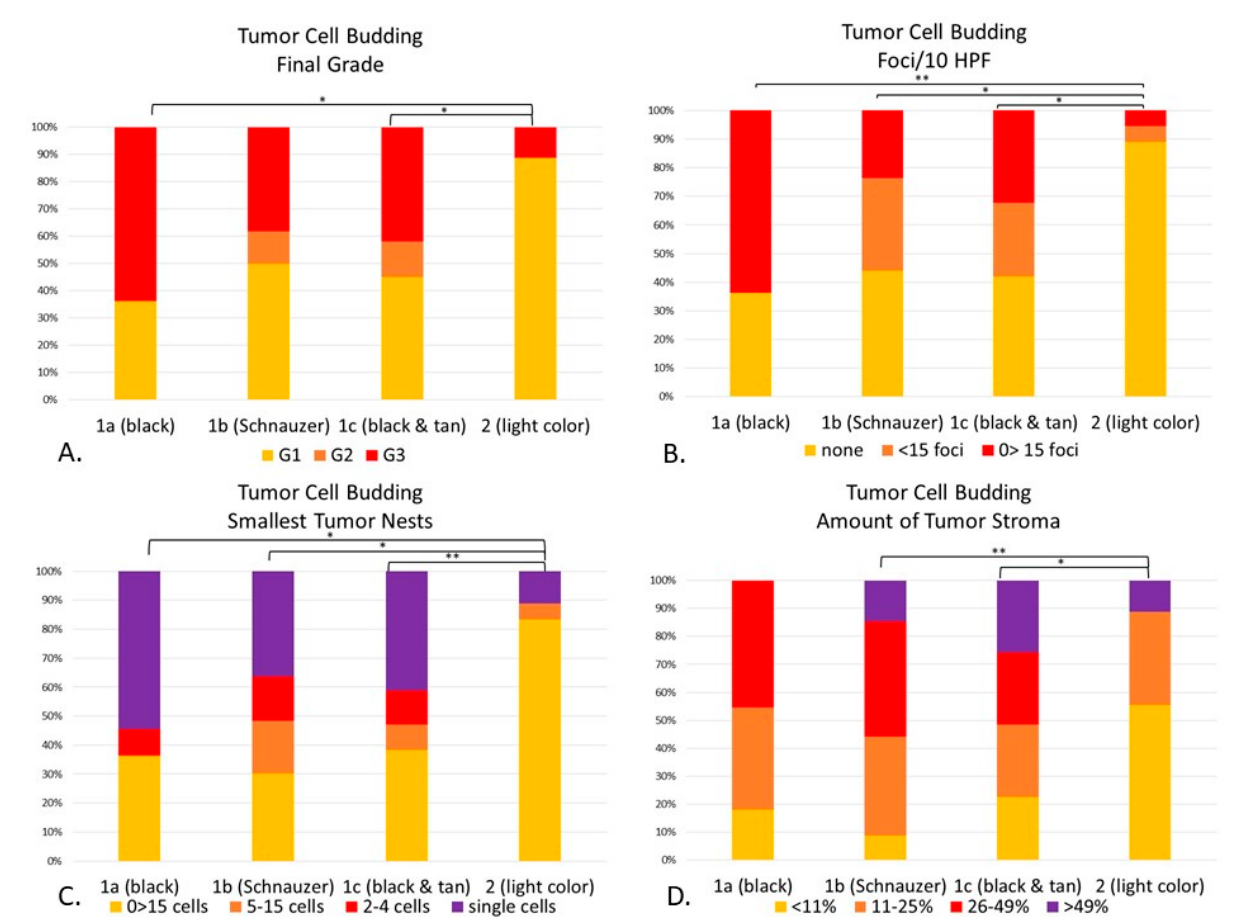
Figure 10. ( A – D ). Statistical differences between genetically defined subgroups (1a–1c) and Group 2 according to the tumor cell budding system. Cellular dissociation final grade ( p < 0.01), with statistical differences in Group 1a ( p < 0.05), and 1c ( p < 0.05) when compared to Group 2 ( A ). Budding/10 HPF ( p < 0.01) was different between Groups 1a ( p < 0.01), 1b ( p < 0.05) and 1c ( p < 0.05) when compared to Group 2 ( B ). Smallest tumor nest size ( p < 0.01) was significantly different between Groups 1a ( p < 0.05), 1b ( p < 0.05) and 1c ( p < 0.01) when compared to Group 2 ( C ). The amount of tumor stroma ( p < 0.01) was statistically different between Groups 1b ( p < 0.01) and 1c ( p < 0.05) when compared to Group 2. There were no statistical differences among dark breeds when compared to each other. ( D ) The amount of tumor stroma of Group 2 was statistically significant when compared to Group 1b ( p < 0.01) and 1c ( p < 0.05). * p < 0.05; ** p < 0.01.